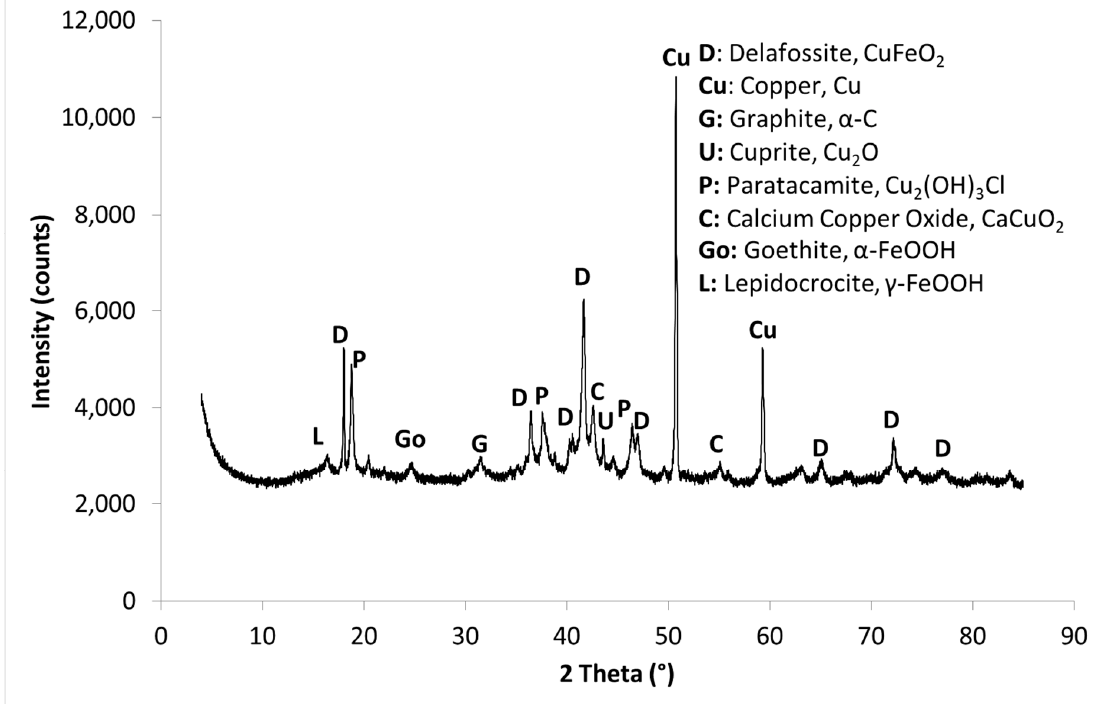
Figure 3. X-ray di ff raction (XRD) pattern of the abrasion product obtained from Ferrodecont treatment Figure 3. X-ray diffraction (XRD) pattern of the abrasion product obtained from Ferrodecont of sample treatment of sample A.